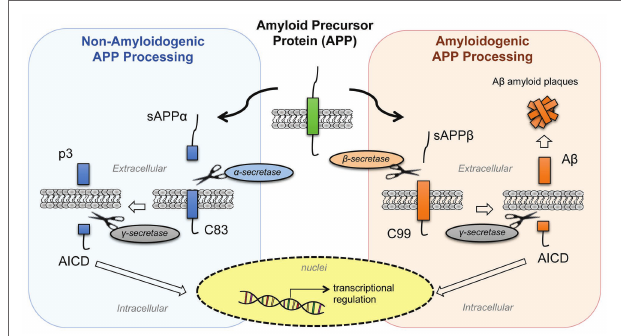
FIGURE 1 | Processing of amyloid precursor protein (APP). APP is processed by two proteolytic pathways: the non-amyloidogenic processing (in blue) and the amyloidogenic processing (in orange). The non- amyloidogenic processing releases in the extracellular space sAPP α and p3 fragments, while the amyloidogenic processing releases sAPP β and β -amyloid (A β ) peptides. Both pathways release APP intracellular domain (AICD) fragments into the intracellular space that then translocate to the nuclei and regulate cellular transcription. [sAPP α , soluble amyloid precursor protein; p3, APP non-amyloidogenic extracellular fragment; C83 ( β CTF), APP C-terminal fragment beta; AICD, APP intracellular domain; sAPP β , soluble amyloid precursor protein cleaved by β -secretase; A β , beta-amyloid peptide; C89 ( α CTF), APP C-terminal fragment